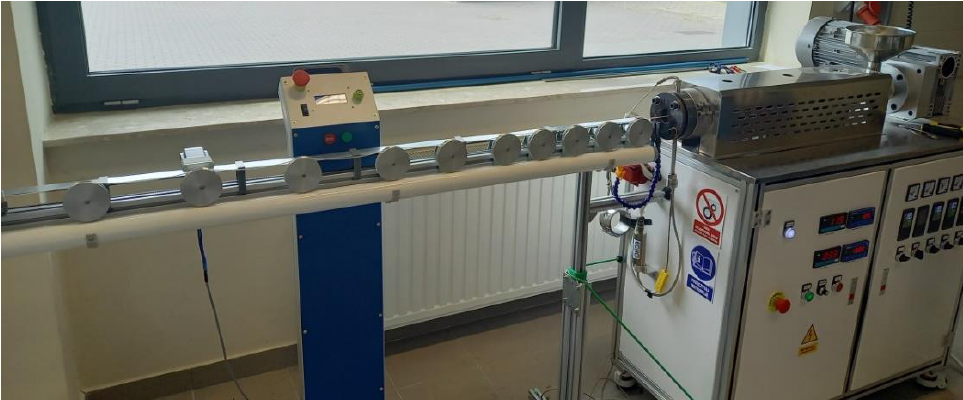
Figure 9. Technological line for the production of filaments.